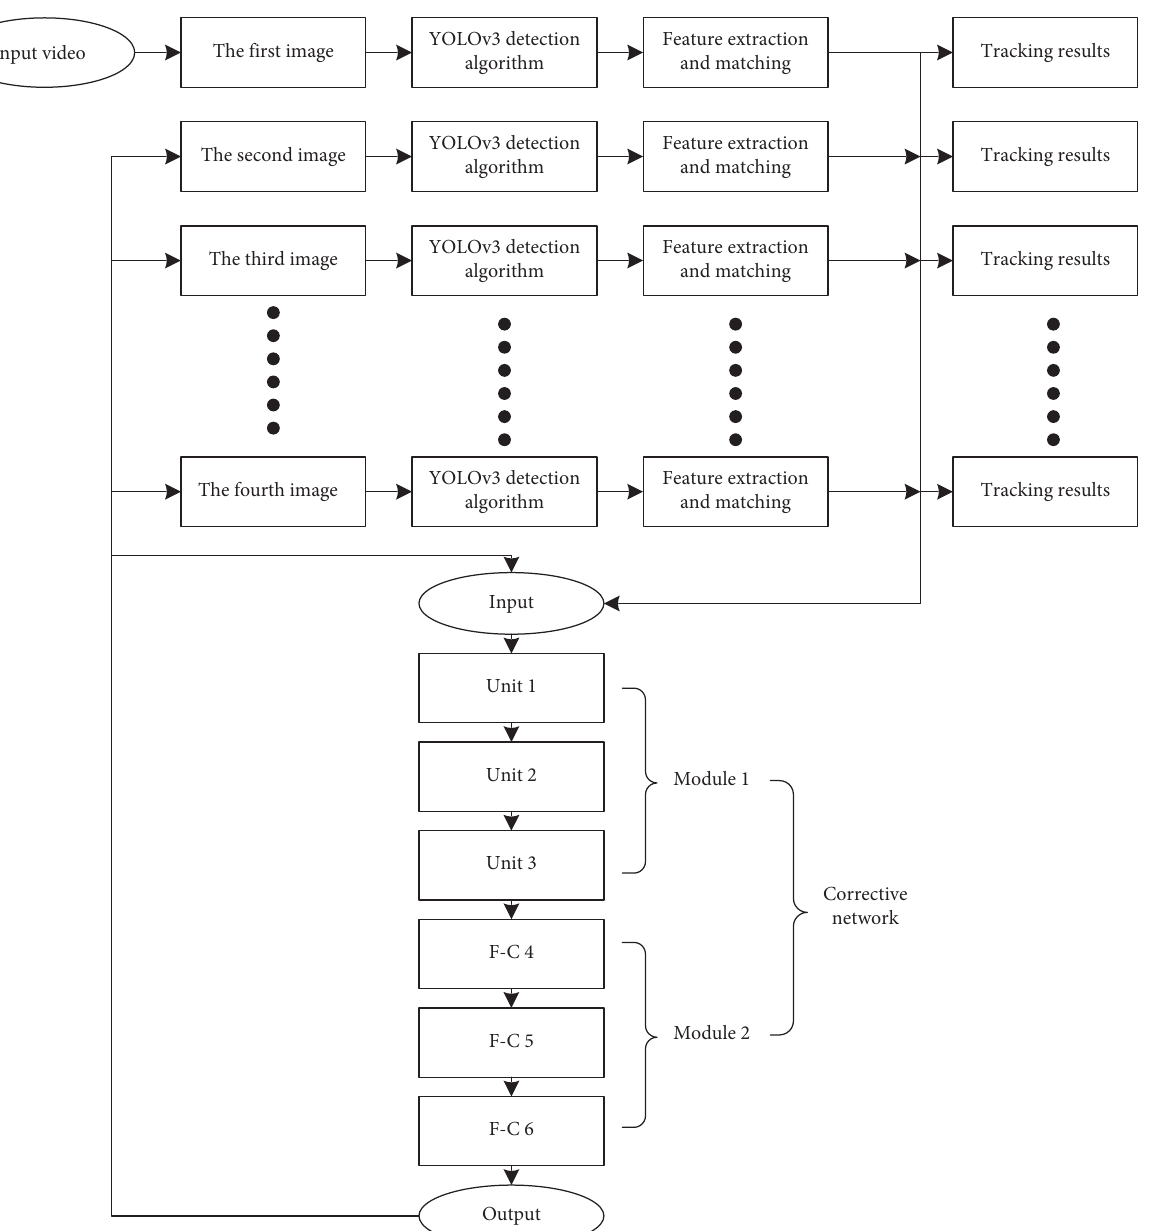
Figure 3: Integrated network structure